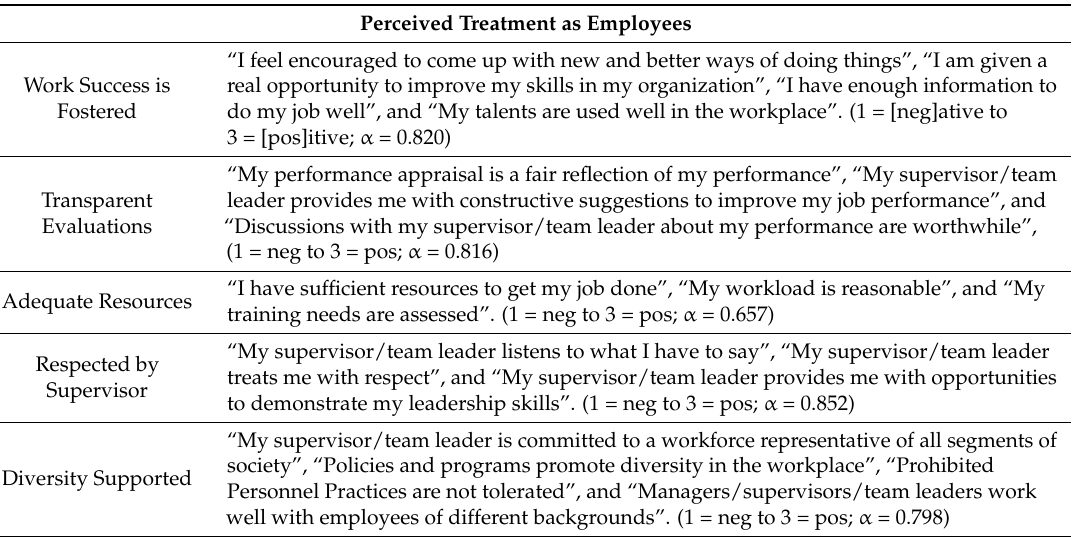
Table 1. Operationalization of workplace experience dependent